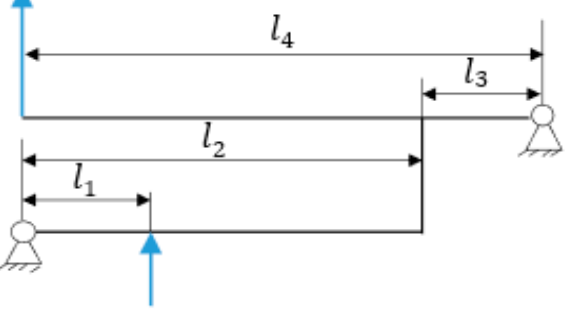
Figure 4. Schematic diagram of the lever amplification mechanism.